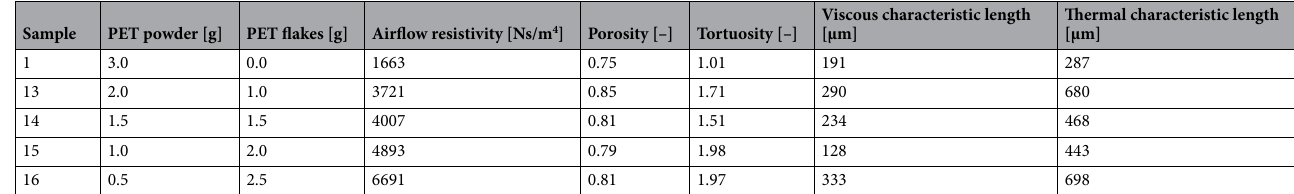
Table 10. JCA model parameters for different combinations of microplastics.